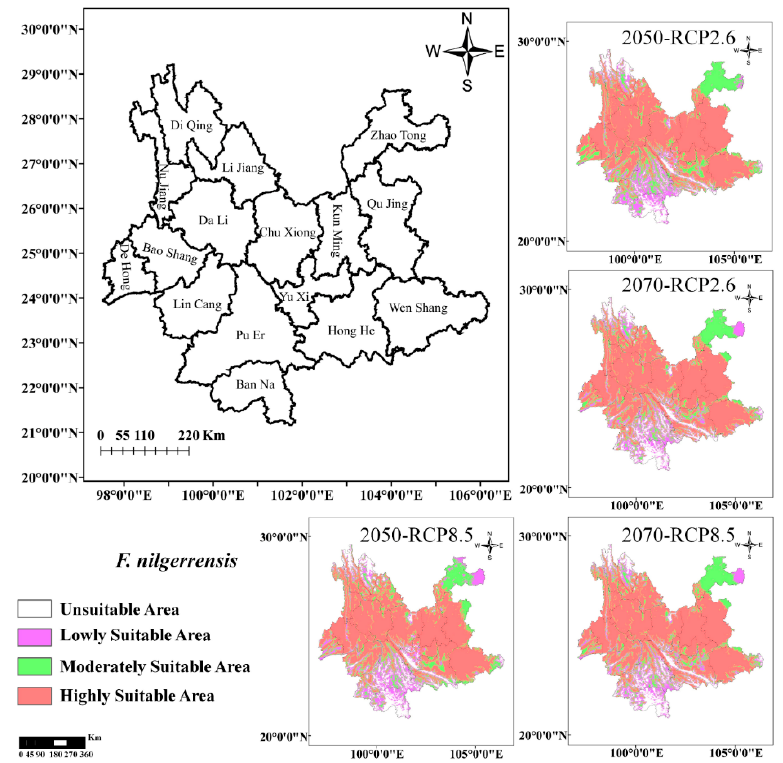
Figure 5. Potentially suitable areas for F. nilgerrensis under four climate scenarios in Yunnan Province (2050-RCP2.6, 2050-RCP8.5, 2070-RCP2.6, and 2070-RCP8.5 were four climate scenarios). “Current” represents current scenario (1970 to 2000); “RCP2.6” represents the minimum greenhouse gas scenario, and “RCP8.5” represents the maximum greenhouse gas scenario; “2050” and “2070” represent two periods of the 2050s (2041 to 2060) and 2070s (2061 to 2080), respectively.